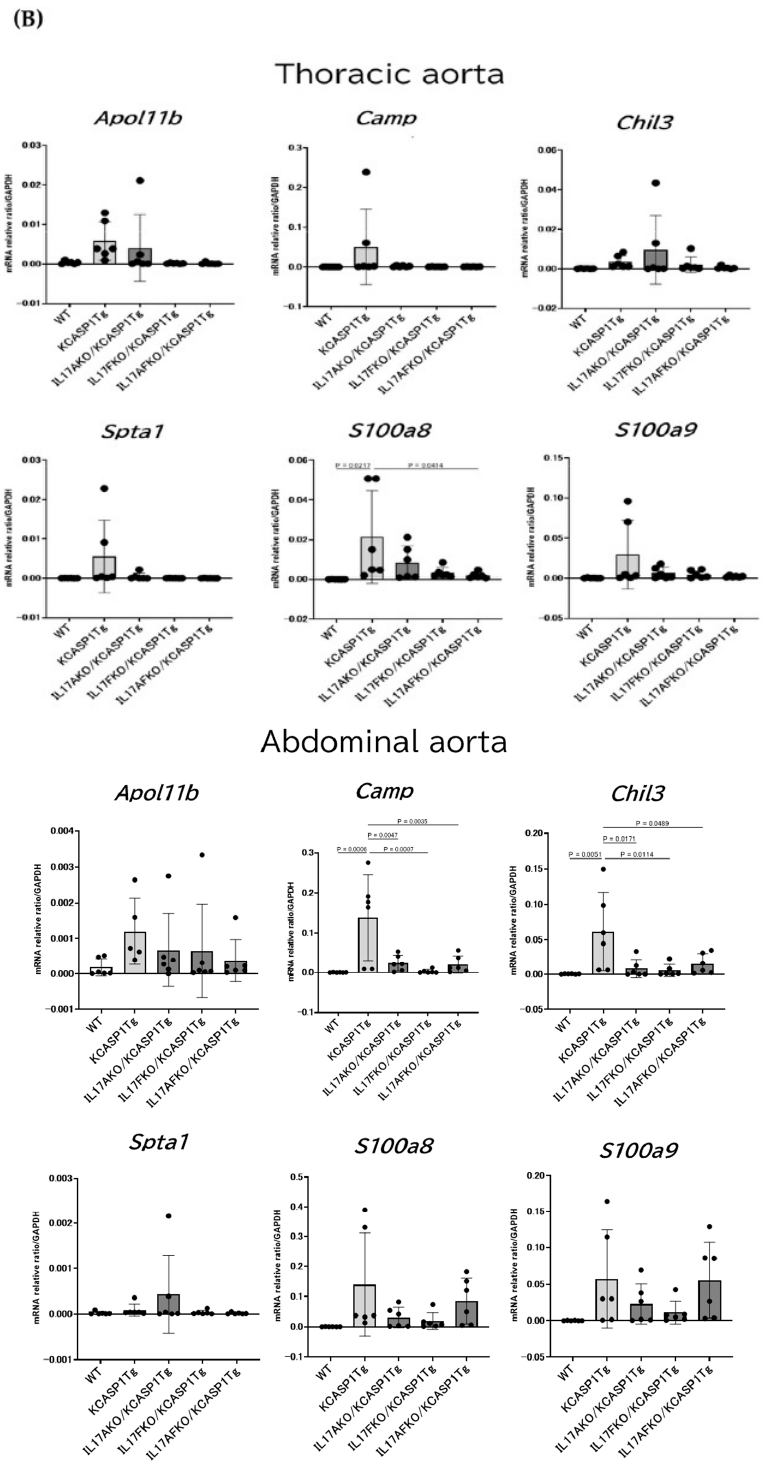
Figure 5. The effect of arteriosclerosis by IL-17 deficiency. The circumference of the lumen of the artery was recovered at the abdominal portion in KCASP1Tg mice when crossing with IL-17A-, IL- 17F-, and IL-17AF- mice. In addition, IL-17A-, IL-17F-, and IL-17AF- mice tended to have an enlarged aorta ( A ). The mRNA expression levels for the enhanced gene in KCASP1Tg mice were partially ameliorated in IL-17KO KCASP1Tg mice. n = 6, each group. Statistical analysis was performed with the Ordinary one-way ANOVA followed by Tukey’s multiple comparison tests ( B